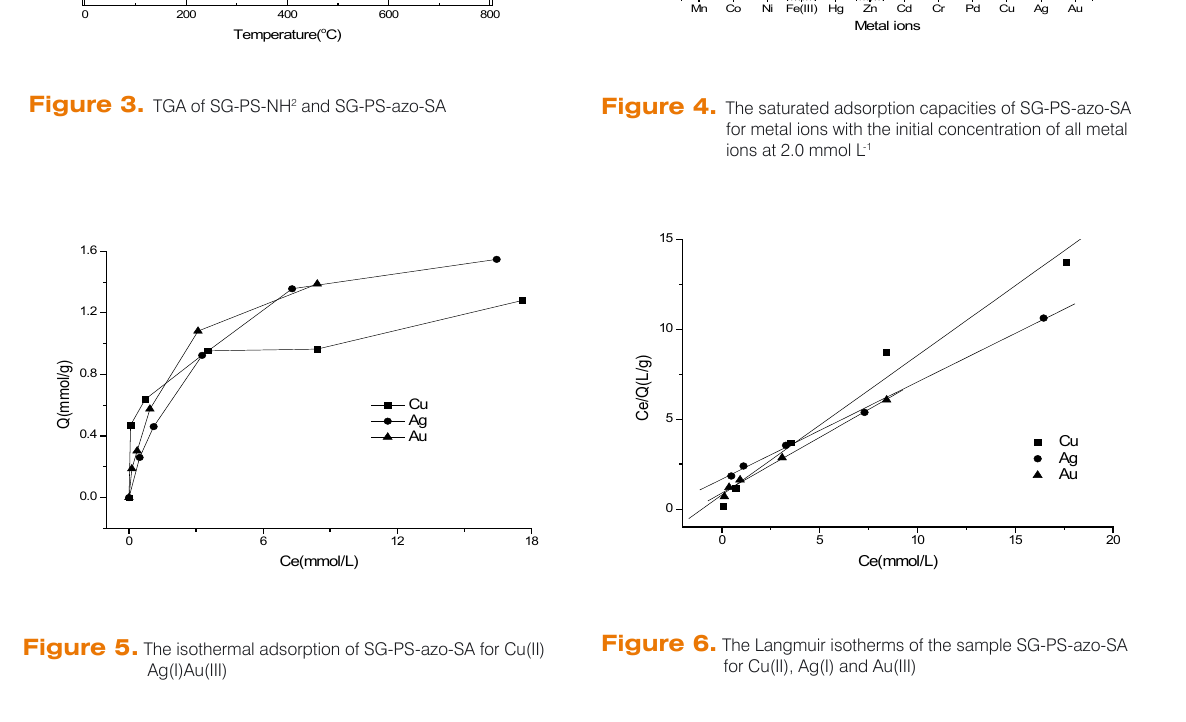
Figure 5. The isothermal adsorption of SG-PS-azo-SA for Cu(II) Ag(I)Au(III)